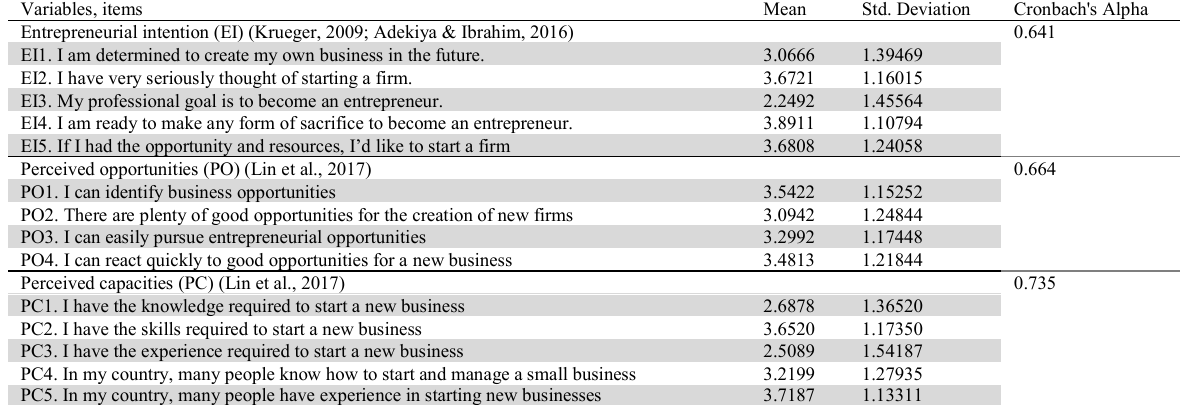
Reliability test and descriptive statistics for variables Variables, items